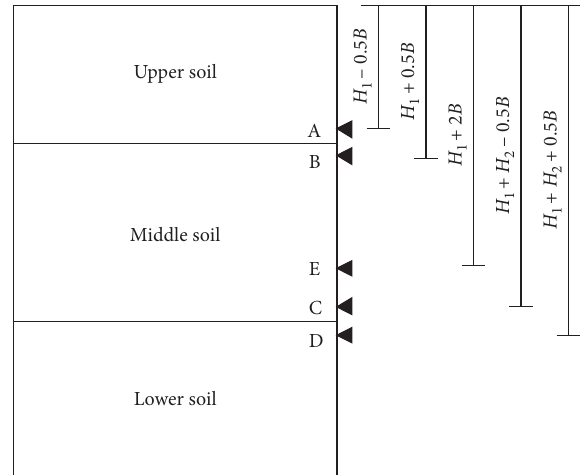
Figure 9: Variation in N c , l with the upper soil thickness H 1 ( α � 0.3).